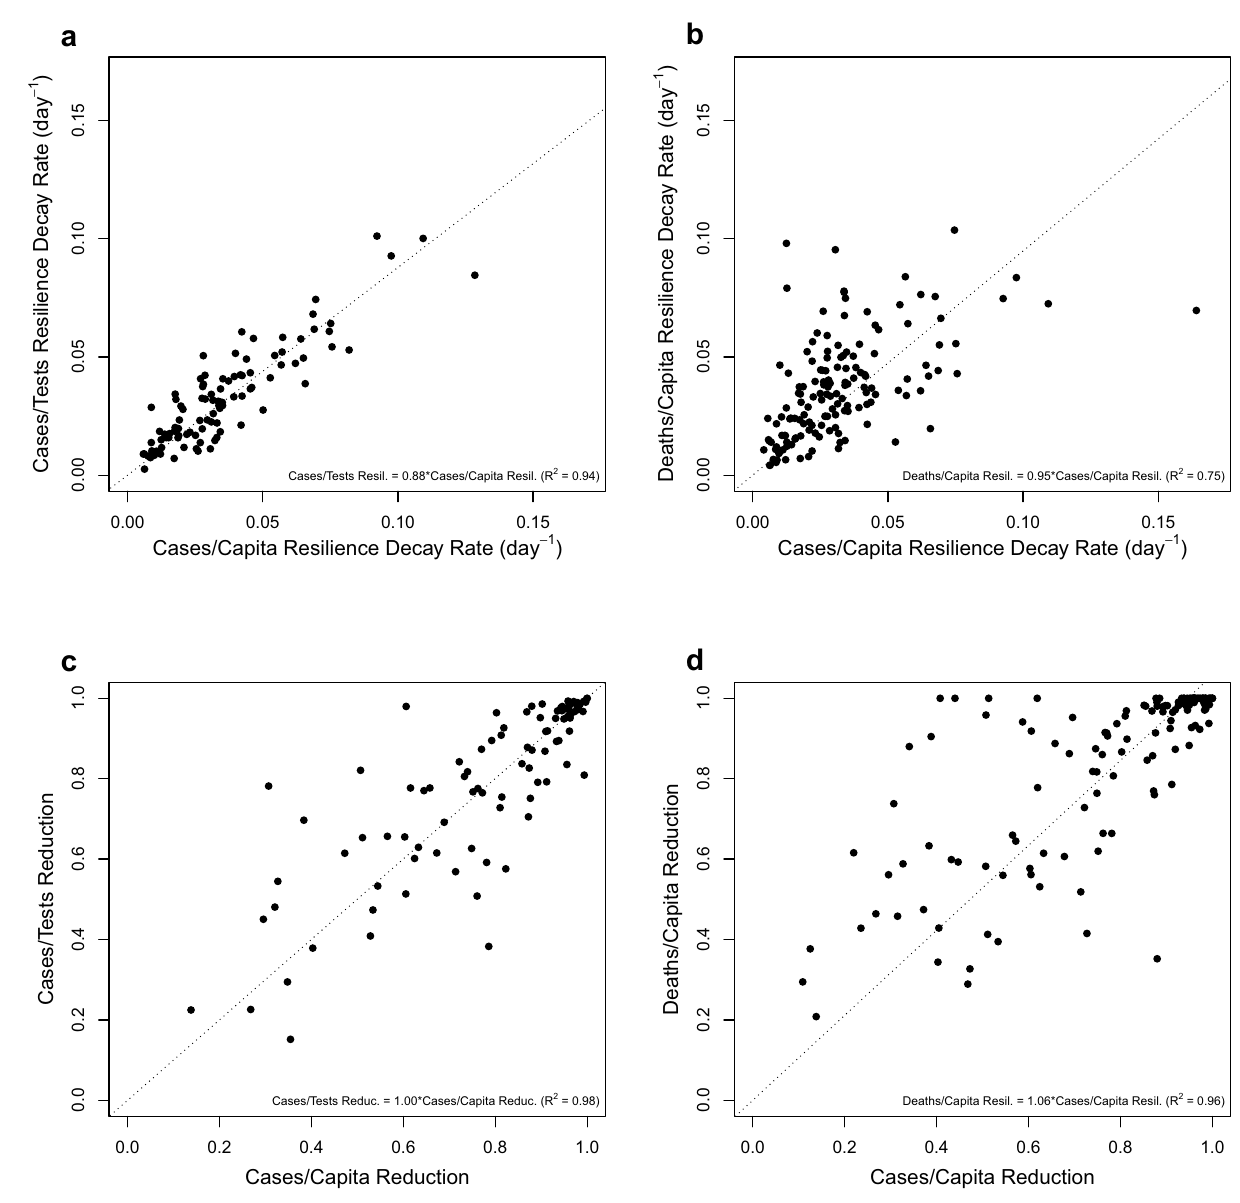
Figure 1. Comparing country-level COVID-19 resilience and reduction results for cases/capita, cases/tests, and deaths/capita. ( a ) resilience of cases/capita vs cases/tests (n = 100, ρ =0.86, p < 0.0001). ( b ) resilience of cases/ capita vs deaths/capita (n = 150, ρ =0.61, p < 0.0001). ( c ) reduction of cases/capita vs cases/tests (n = 94, ρ =0.83, p < 0.0001). ( d ) reduction of cases/capita vs deaths/capita (n = 136, ρ =0.76, p < 0.0001). Linear correlation results tied to the origin are given within each figure panel and correspond to the dotted